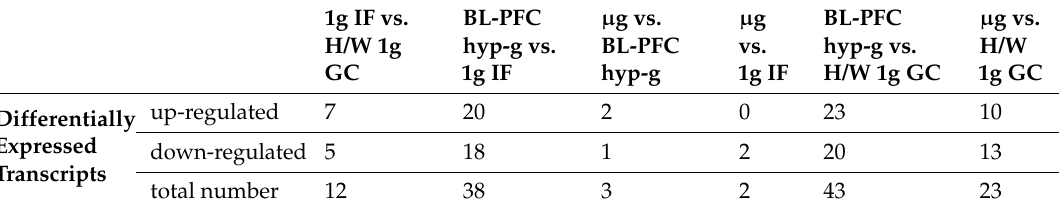
Figure 1. Differentially regulated transcripts (list of genes in Supplementary Table S6) of the oxidative stress response in human U937 myelomonocytic cells during the 19th DLR parabolic flight campaign. The different comparisons and resulting intersections for hypergravity and microgravity-sensitive transcripts are displayed as venn-diagramms. In the circles numbers of transcripts are given that are differentially expressed according to fold changes ≤ − 1.3 or ≥ +1.3, p < 0.05 in the respective comparison. ( a ) Number of hyper-g sensitive transcripts. ( b ) The red area shows the number of 1g IF-controlled hyper-g-sensitive transcripts: differentially expressed in the comparison BL-PFC hyp-g versus 1g IF excluding those differentially expressed in the control comparison 1g IF versus H/W 1g GC. ( c ) The red area shows the number of BL-controlled microgravity-sensitive transcripts: differentially expressed in the comparison µ g versus BL-PFC hyp-g excluding those differentially expressed in the control comparison BL-PFC hyp-g versus H/W 1g GC. ( d ) The red area shows the number of 1g IF- and BL-controlled microgravity-sensitive transcripts: differentially expressed in the comparison µ g versus BL-PFC hyp-g excluding those differentially expressed in the control comparisons BL-PFC hyp-g versus 1g IF and 1g IF versus H/W 1g GC. For the abbreviations of the experiment group names see Table 1. Table 2. Numbers of transcripts that are differentially expressed in response to altered gravitational conditions in the 19th DLR parabolic flight campaign. Transcripts that were significantly changed in the control comparisons were eliminated. Differential expression is defined as t -test p -value < 0.05; fold change (FC) ≤ − 1.3 or ≥ +1.3. FCs are ratios between the averages of linear expression values. If the ratio is <1, FC is calculated as the negative reciprocal of the ratio. For the abbreviations of the experiment group names see Table